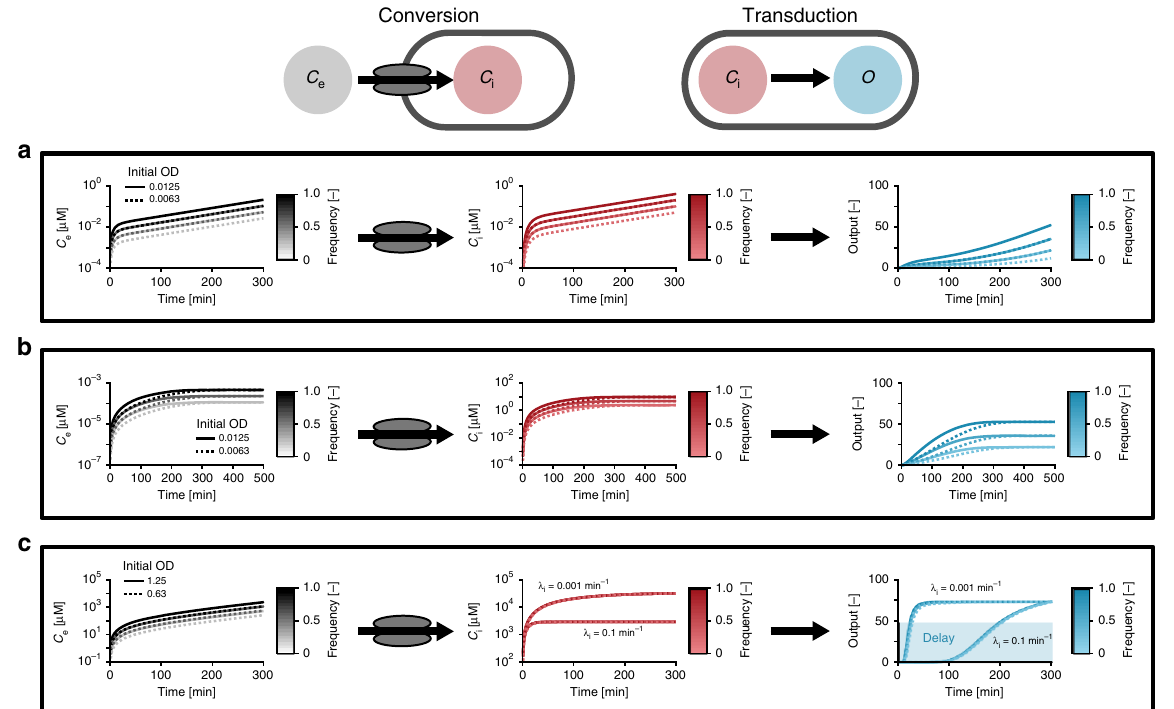
Fig. 2 Pump – probe networks could execute various regulatory functions. The results from simulations of the pump – probe model. A population of cells, suspended in a volume V e = 10mL, grows exponentially at a rate µ = 0.55h − 1 . The initial population size is given by the inoculum N 0 = α ×OD 600nm , where α = V 8 cells mL − 1 . Starting at t = 0, a fraction of cells f produces the signal at a rate π . The results are shown for an initial OD e (mL)×1.19×10 (solid lines) and OD 600nm = 0.0063 (dotted lines) and for a homogenous ( f = 1) and two heterogeneous populations ( f = 0.5, 0.25, line color set by to the color bar). Active uptake ( “ pumping ” ) of the signals into the cells converts the extracellular signal C e into an intracellular signal concentration C i , which is probed by the receptor and transduced into an output O . a Quorum sensing control : C e and C i continue to rise as the population grows. The output tracks changes in the density of signal-producing cells, and varies both with the inoculum and f . Parameters: K M = 1.40mM, v max = 0.31 amol min − 1 , π = 1 amol min − 1 , λ e = 0.1min − 1 , λ = 0.1min − 1 ; n = 1, EC = 0.37 µ M. b Ratiometric control : Despite continuous population growth, the signal concentrations and the output approach a steady i 50 state that depends on f . Parameters: K M = 140nM, v max = 0.31 amol min − 1 , π = 1 zmol min − 1 , λ e = 0min − 1 , λ i = 0.1min − 1 , n = 1, EC 50 = 8.5 µ M. c Chronometric